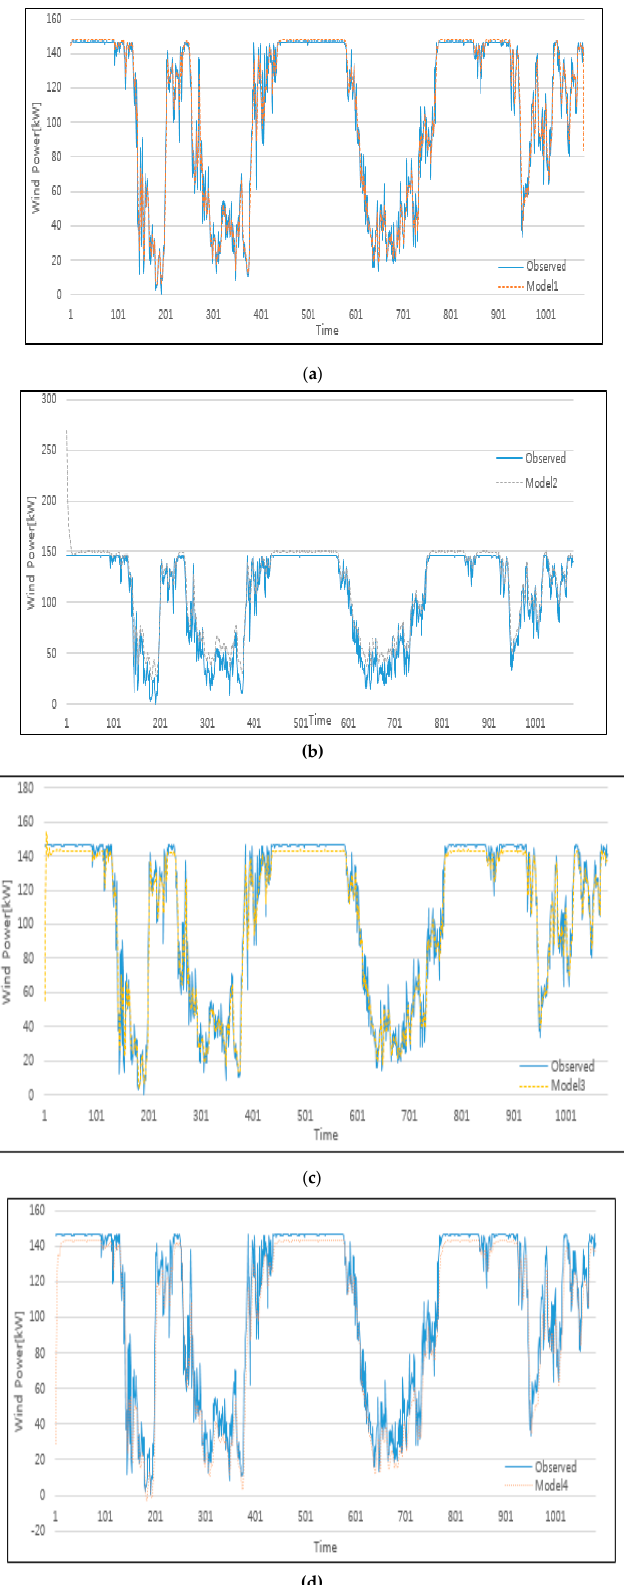
Figure 9. Comparison of wind power prediction by models using the proposed long short-term memory in A region of Jeju Island: ( a ) Comparison of observed value with Model 1; ( b ) Comparison of observed value with Model 2; ( c ) Comparison of observed value with Model 3; ( d ) Comparison of observed value with Model 4.